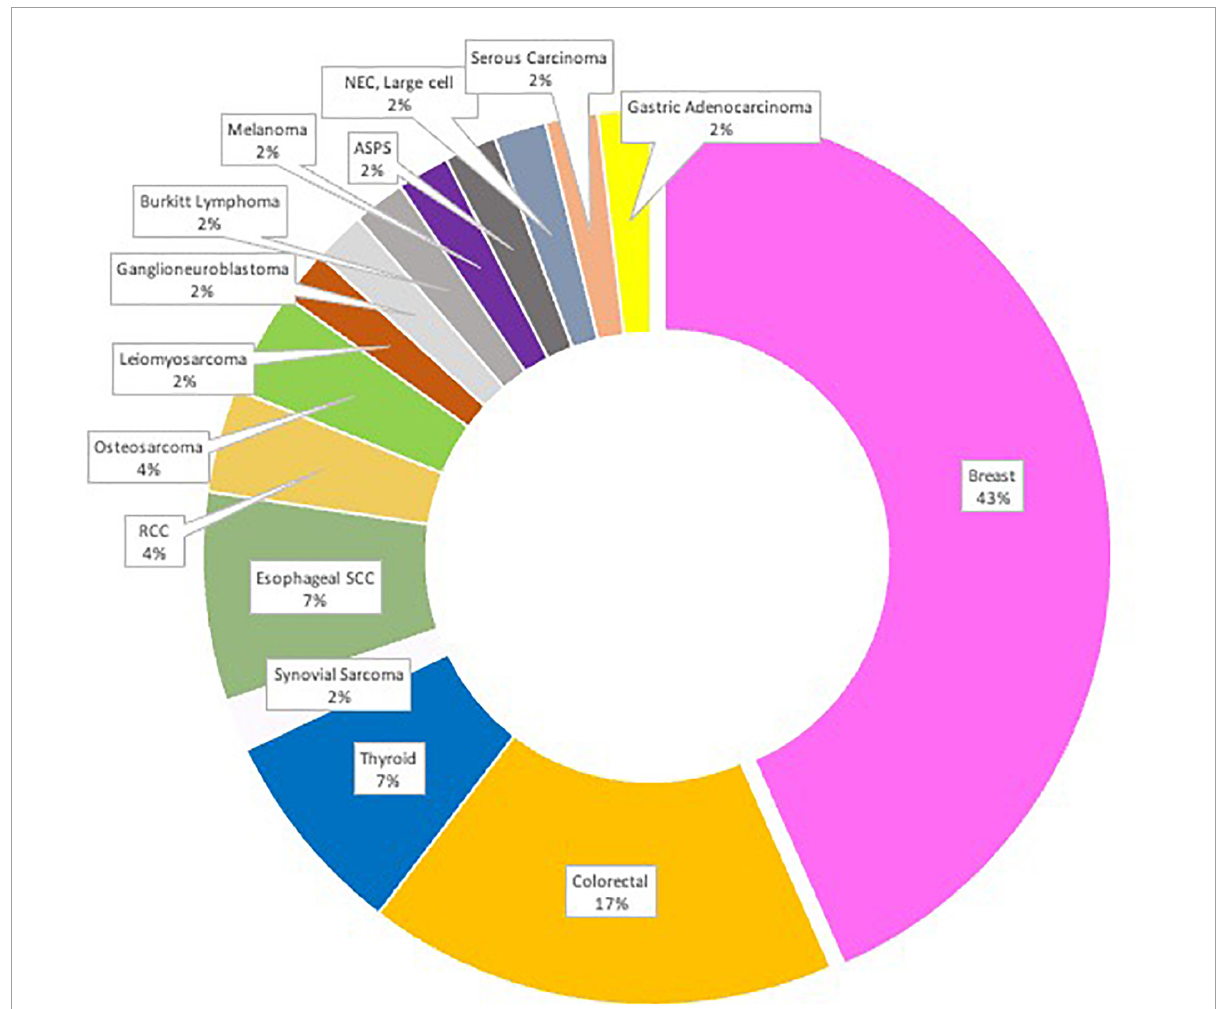
FIGURE1 The study cohort ( N = 50) distribution by location of primary tumor with corresponding metastatic CNS